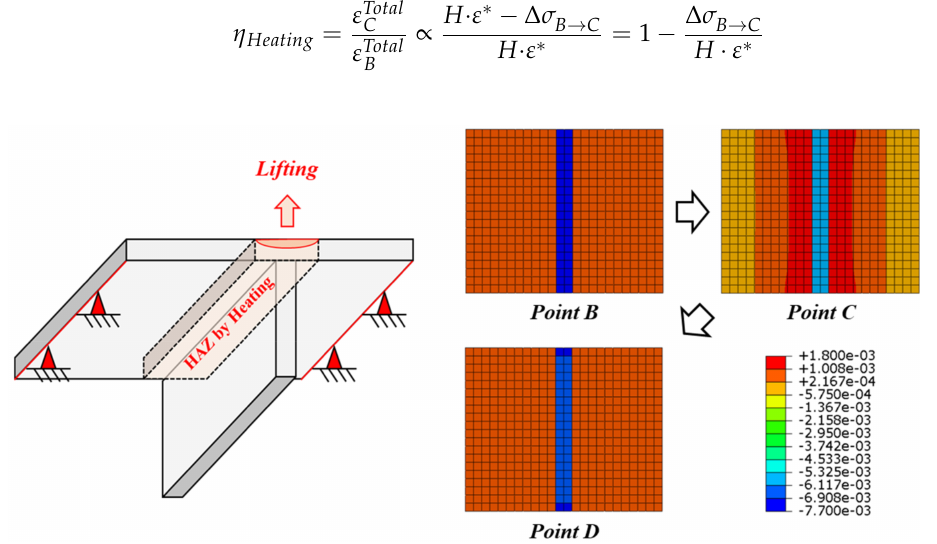
Figure 9. Inherent strain change in the line heating area by tensile stress.